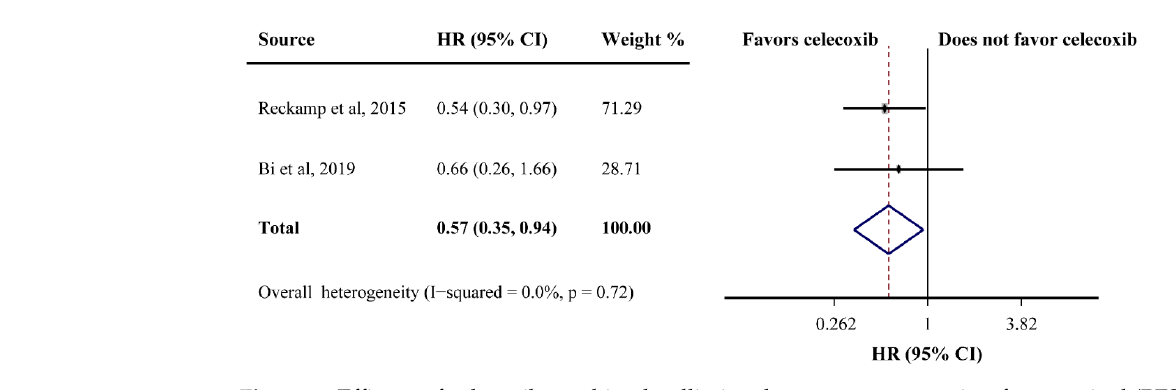
Figure 3. Efficacy of celecoxib-combined palliative therapy on progression-free survival (PFS) for EGFR wild-type status patients. HR: hazard ratio; CI: confidence interval [48,59].